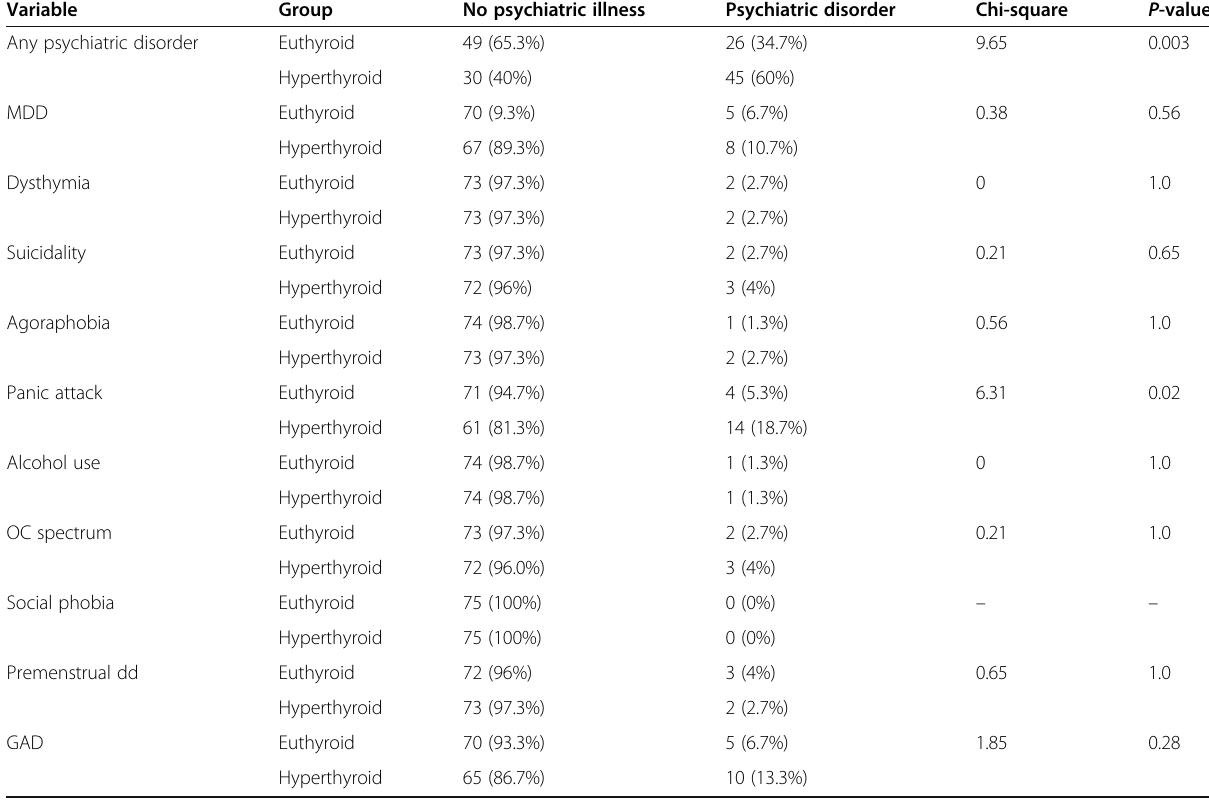
Table 3 Proportion of psychiatric disorders among patients with